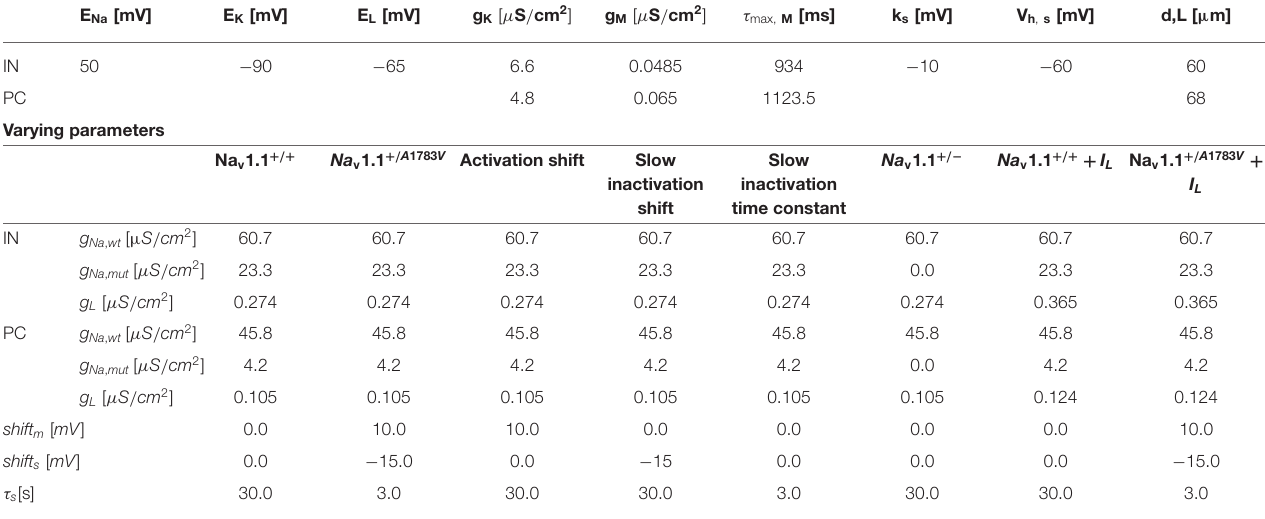
TABLE 1 | Simulation parameters for the cortical neuron models.